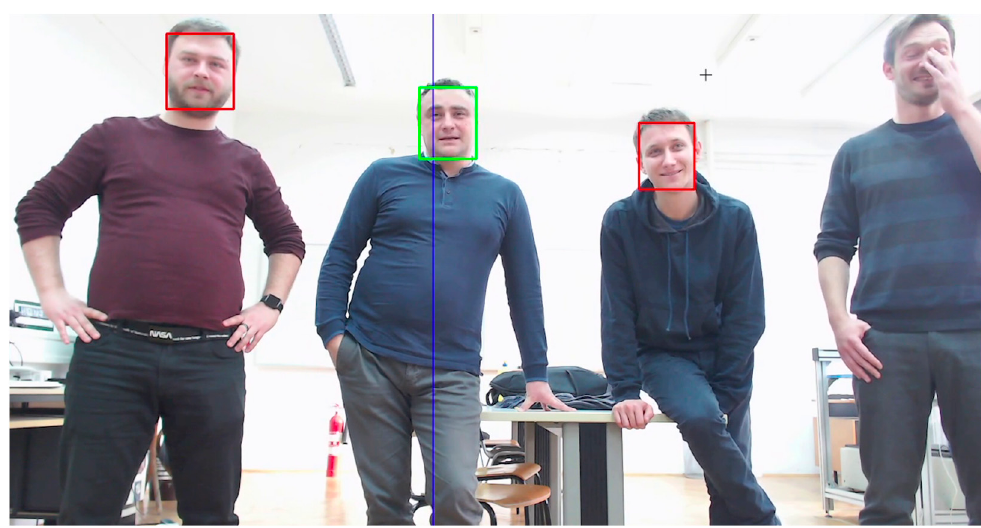
Figure 10. Speaker 2